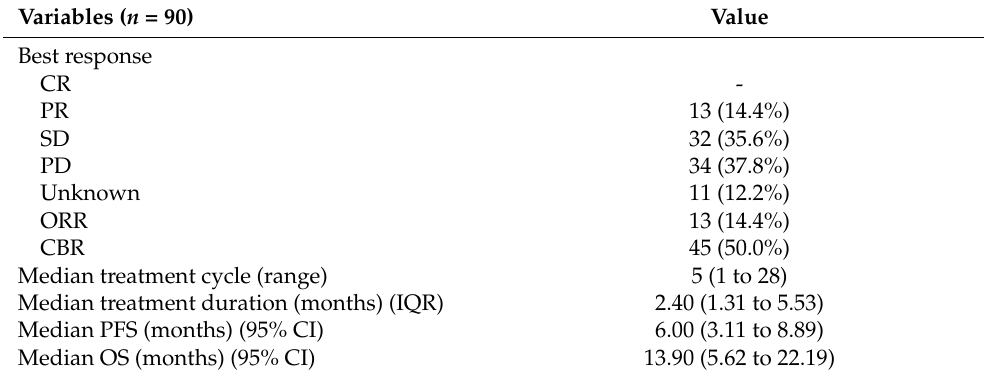
Table 3. Response and survival